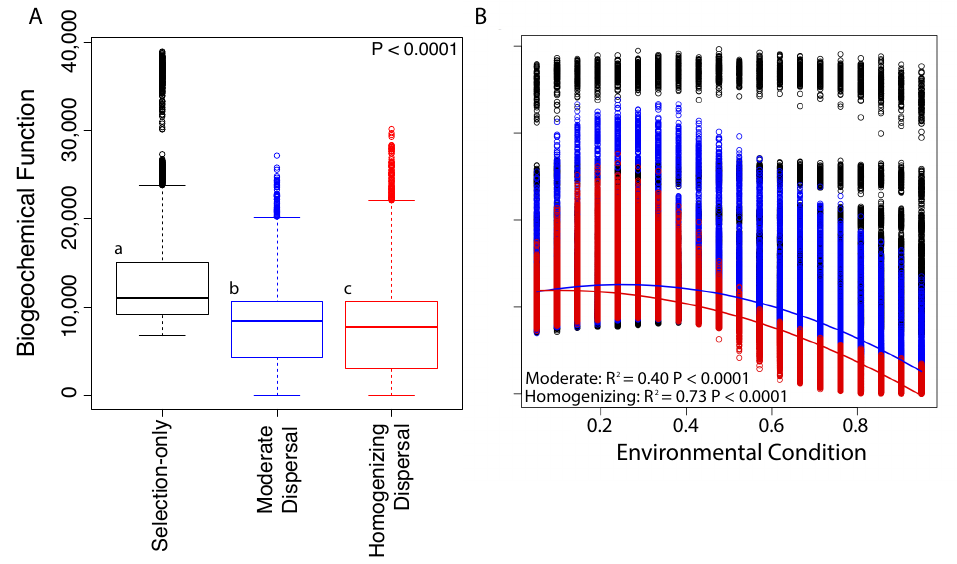
Figure 4. ( A ) Biogeochemical function across dispersal cases. Upper and lower hinges of the box plot represent the 75th and 25th percentiles and whiskers represent 1.5 times the 75th and 25th percentiles, respectively. Different letters indicate statistically significant differences in mean values. ( B ) Biogeochemical function across environmental conditions in receiving communities (vertical axis is the same as in panel A). In the selection-only case (black), biogeochemical function did not vary with environmental condition such that no regression line is drawn. With moderate (blue) and homogenizing (red) dispersal, biogeochemical maxima occurred when the receiving community’s environmental condition aligned with the environmental optima of species in the source community (compare to Figure 3). For these two cases, quadratic regression was used and resulting models are shown as solid lines (statistics